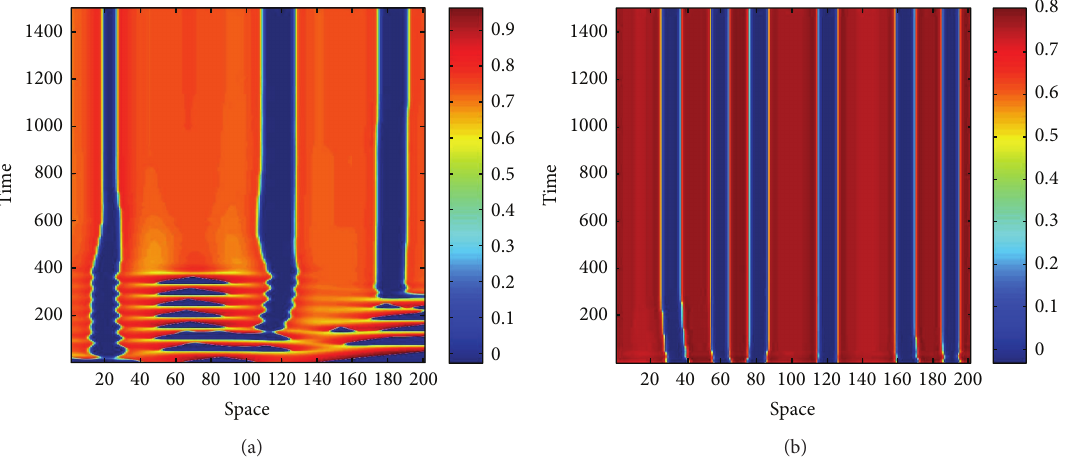
Figure 5: Spacetime plots of prey 𝑢 of model (5). The time interval shown is 1500 . (a) 𝐷 12 = −0.365 and (b) 𝐷 12 = −0.5 . Other parameters are fixed as (27) in the